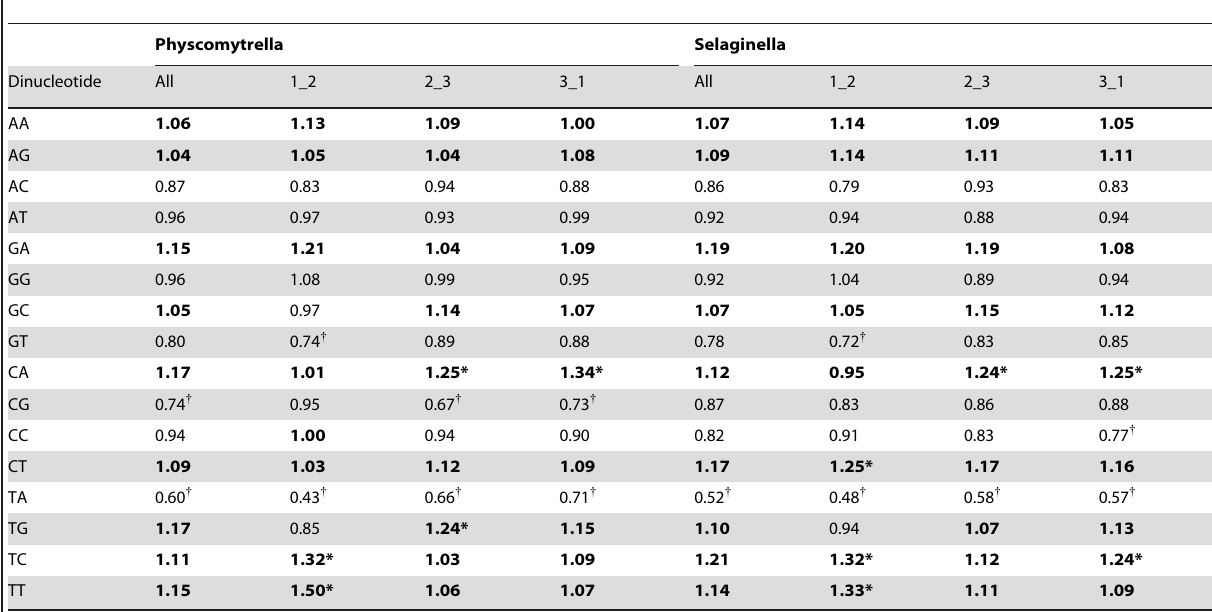
Table 7. Average dinucleotide biases in CDS of Physcomitrella and Selaginella (bold = overrepresented, plain = underrepresented, *=significantely over-represented, { . = significantely